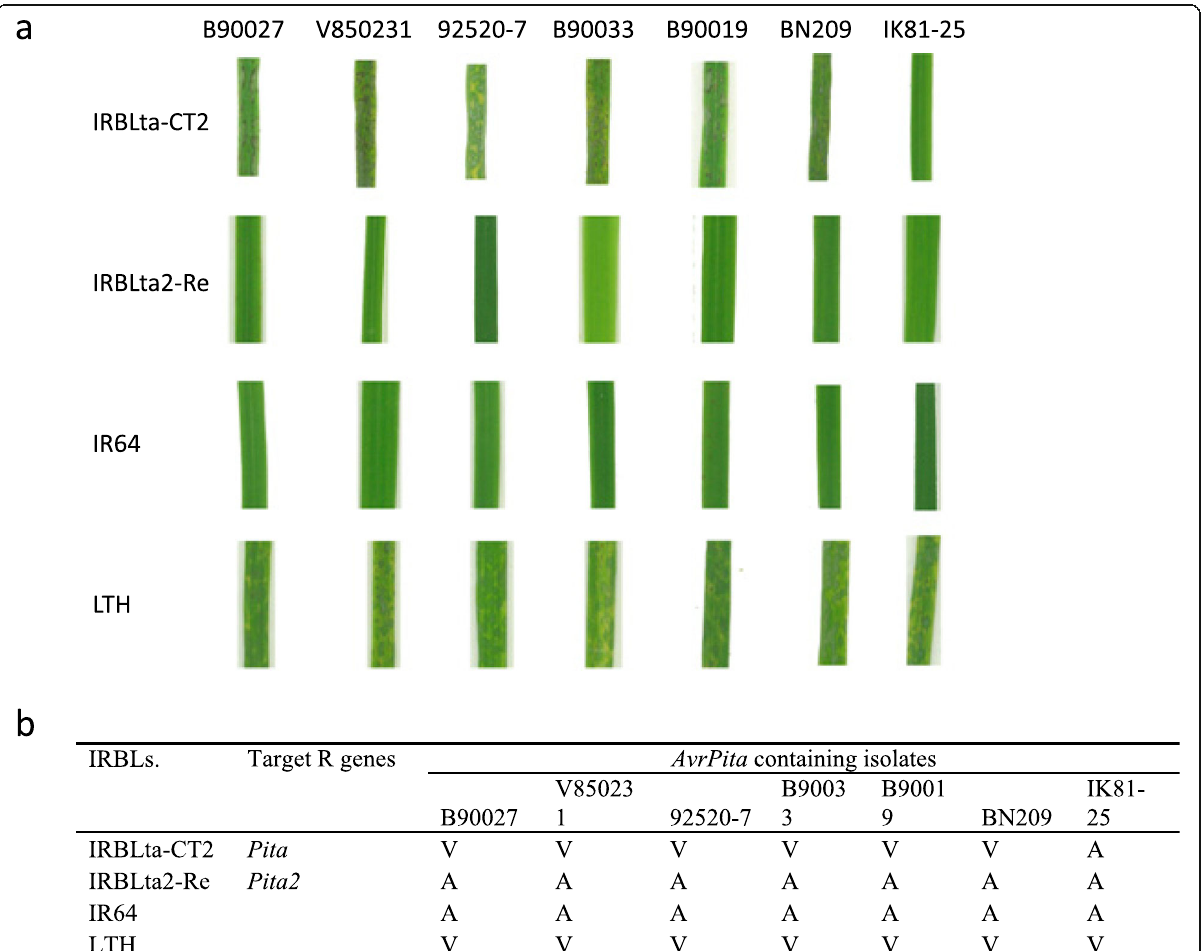
Fig. 3 Disease reaction of AvrPita containing isolates to different rice lines. a Photograph showing disease reaction of 7 AvrPita containing isolates to different rice lines. b Disease reaction of 7 AvrPita containing isolates to different rice lines. A avirulent. V